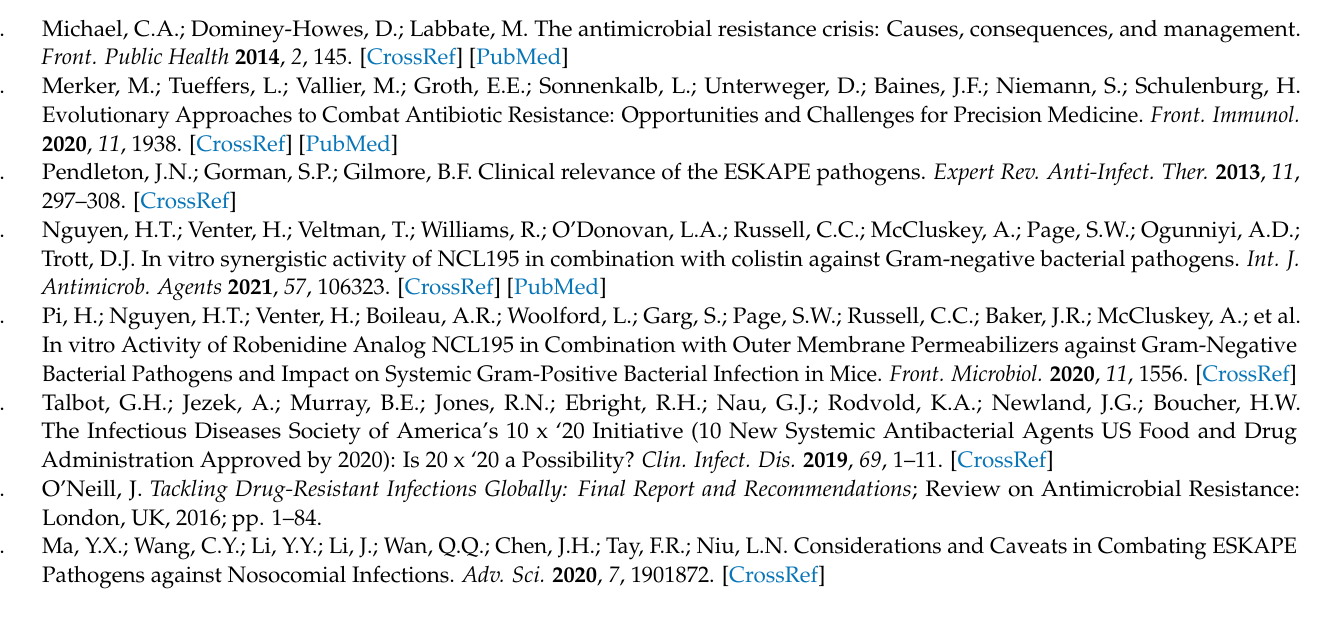
Table S1: Effect of serum on in vitro activity of NCL179 against S. aureus